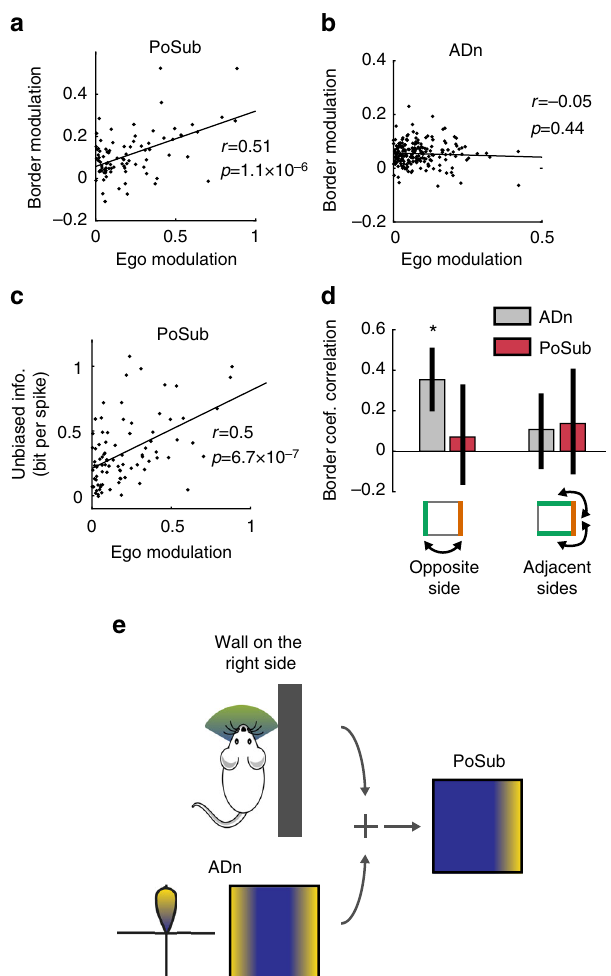
Fig. 3 HD neurons in the PoSub, but not in the ADn, integrate both allocentric (vestibular) and egocentric (self-centered) information to build an unbiased spatial code. a Egocentric modulation of HD neurons in the PoSub correlate with border modulation in for PoSub HD neurons. b Same as a for HD cells of the ADn. c Correlation between egocentric modulation of HD neurons in the PoSub and the amount of unbiased spatial information. d Correlation of the maximal border modulation coef fi cient of each neuron with the coef fi cient associated with the opposite wall (left) or with the adjacent walls (right; the average of the two border coef fi cients is considered in this case). e Schematic diagram of the transformation of an allocentric HD signal into a spatial code for border by a combination with